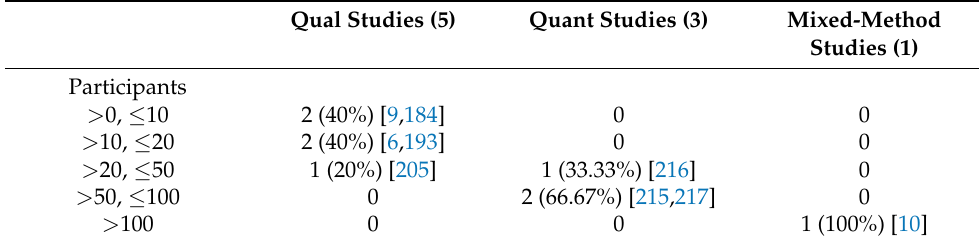
Table 4. Number of study participants for the different user